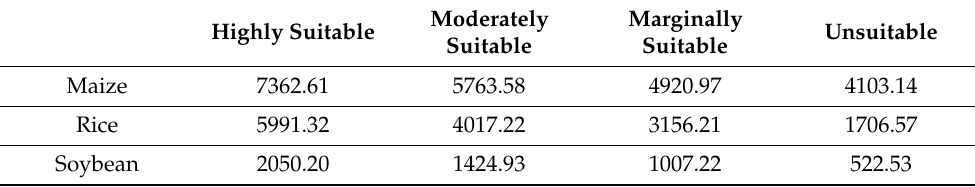
Table 6. The average yields of maize, rice, and soybeans vary in suitability (kg/ha).